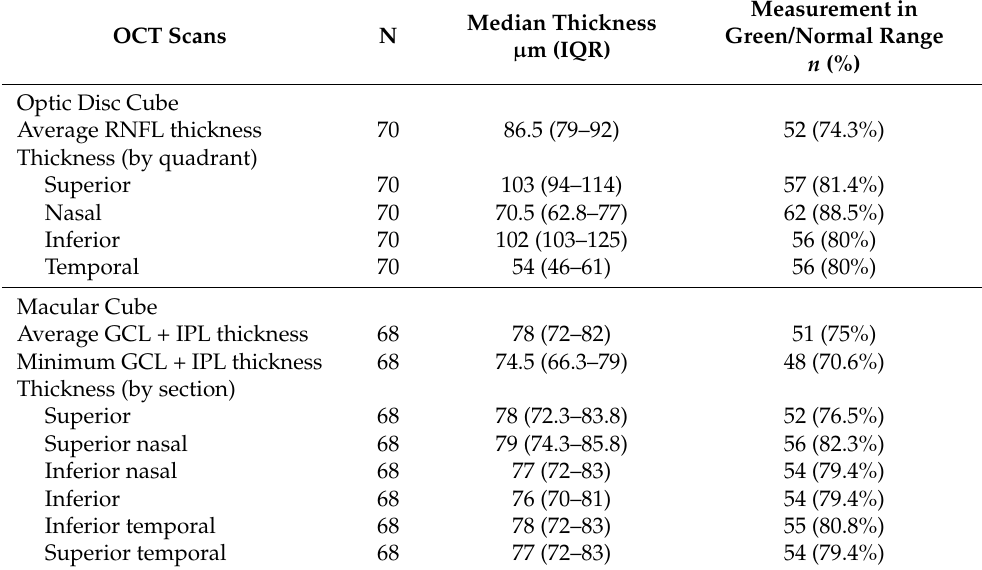
Table 3. Distribution of retinal layer thicknesses measured by optical coherence tomography